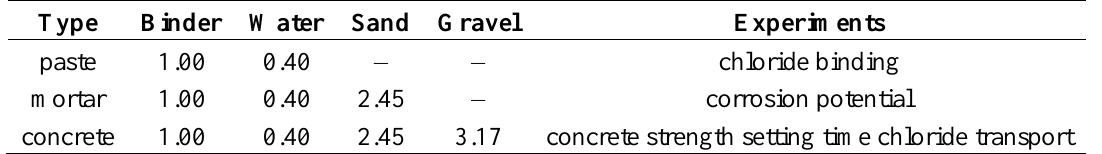
Table 2. Mix proportion for paste, mortar and